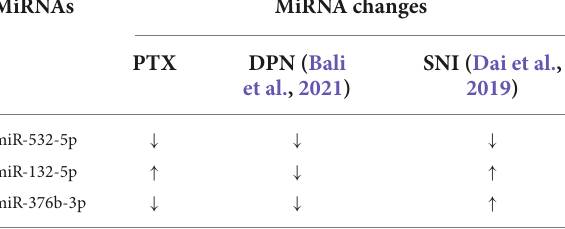
TABLE 5 Differentially expressed circRNA induced by paclitaxel treatment.